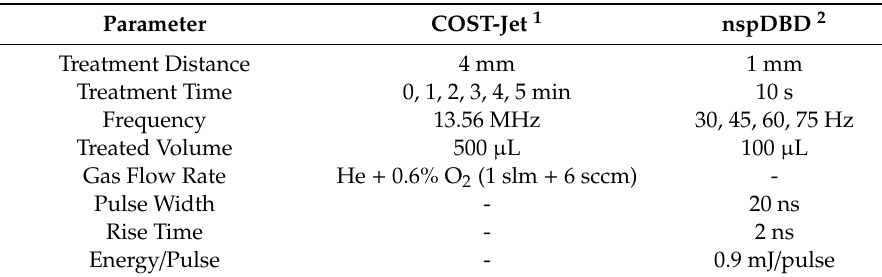
Table 1. Plasma Treatment